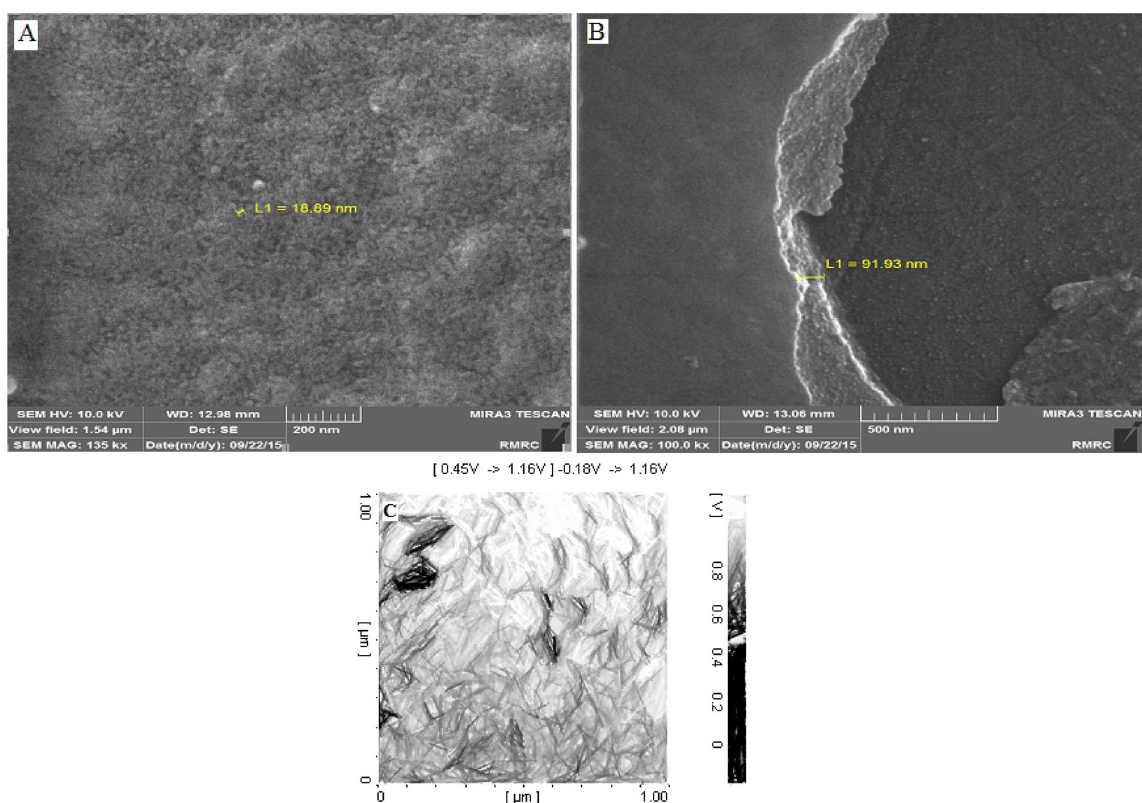
Figure 2. Images of ( A , B ) FE-SEM and ( C ) HR-AFM of electro-synthesized Salen-based polymer as nanowires on the surface of GC electrode during using K + (0.01 mol L −1